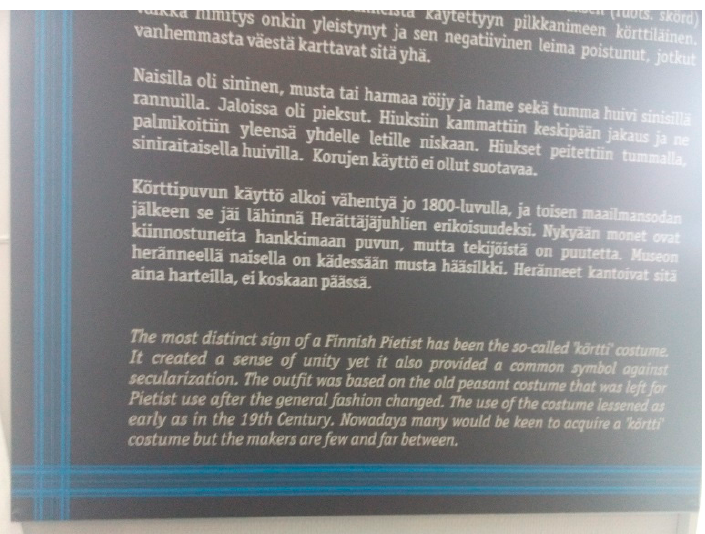
Figure 6. An exhibition plate at the Körtti Museum. Photograph: author.